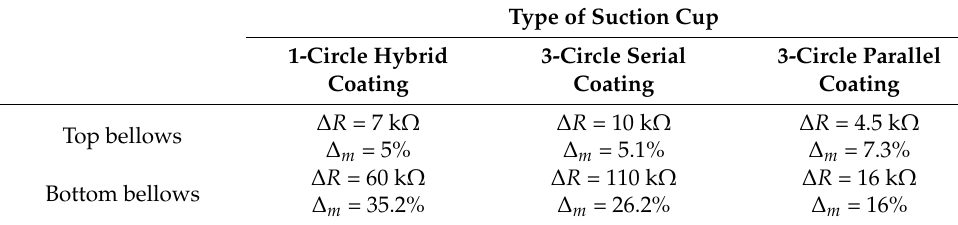
Type of Suction Cup 1-Circle Hybrid 3-Circle Serial 3-Circle Parallel Coating Coating Coating